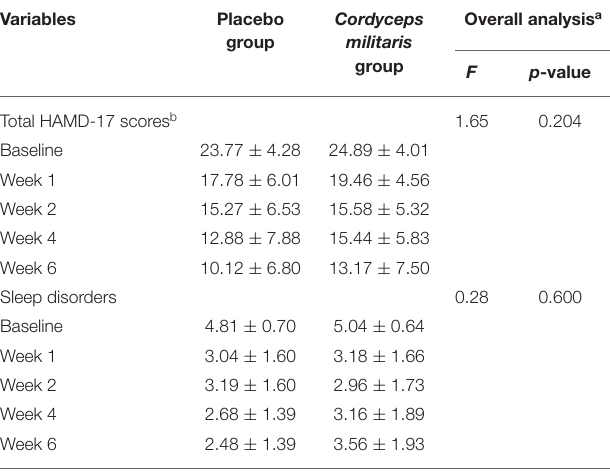
a Overall statistical significance was analyzed using a linear mixed-effect model analysis. Between-group differences were further evaluated using one-way analysis of variance (ANOVA). b HAMD-17,17 items of the Hamilton Depression